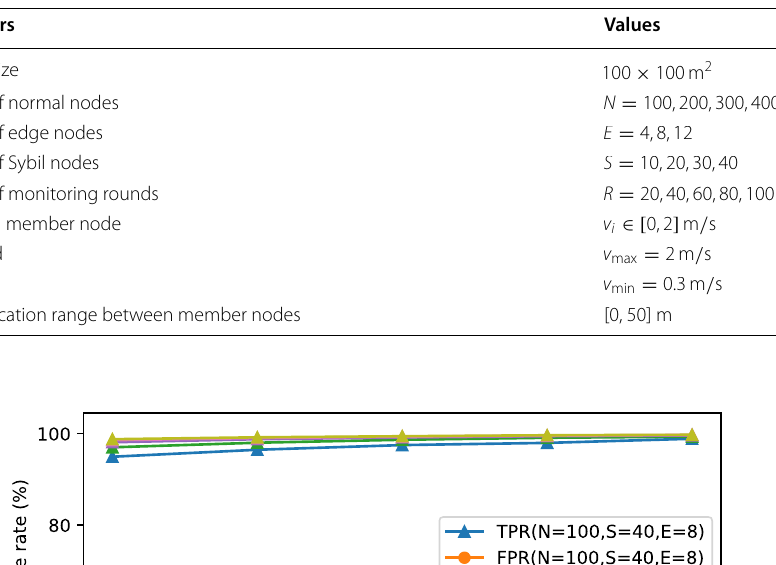
Table 2 Experimental parameters